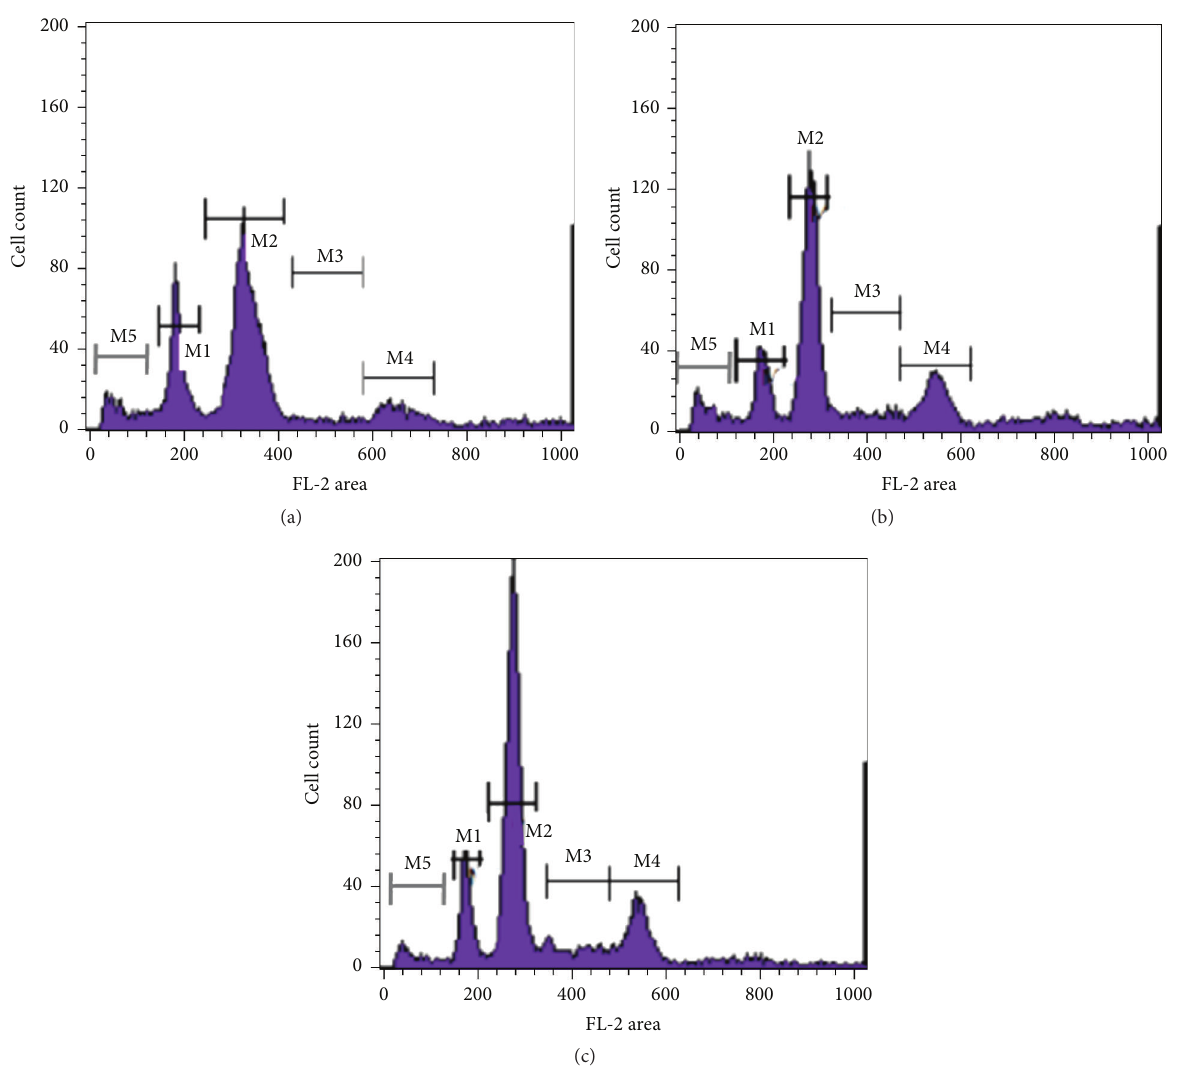
Figure 6: DNA content and cell cycle analysis of (a) control (untreated) breast cancer patient primary tumor cells, (b) breast cancer patient primary tumor cells treated with PTX for 24 h, and (c) breast cancer patient primary tumor cells treated with PTX-ALG nanoparticles for 24 h. M1 gate indicates the G0-G1 phase of diploid cells, M2 gate indicates the G0-G1 phase for the hyperdiploid cells, M3 gate indicates the S phase and M4 gate indicates the G2-M phase for the hyperdiploid cells, and M5 gate indicates the sub-G0-G1 (apoptotic) population. The S and G2-M phases of diploid cells were masked by the phases of hyperdiploid cells. All analysis of cell cycle was after gating of living cells to exclude most apoptotic